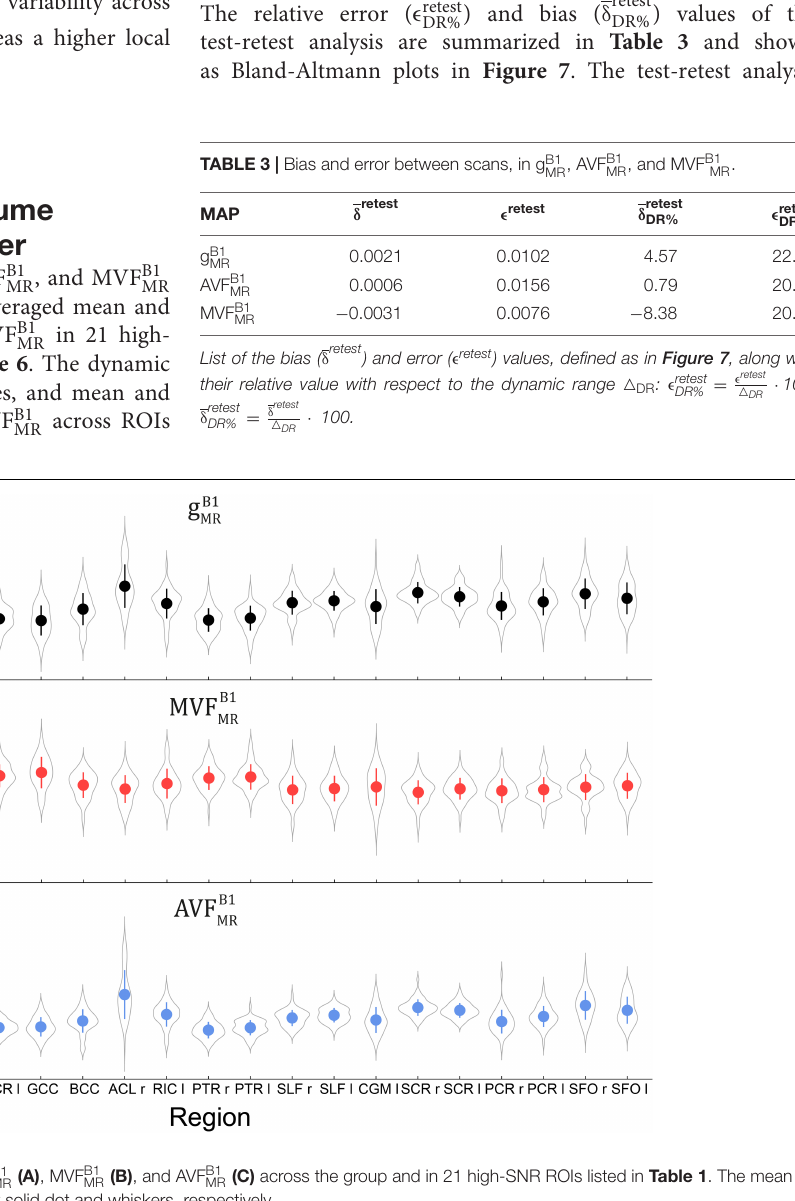
Frontiers in Neuroscience |